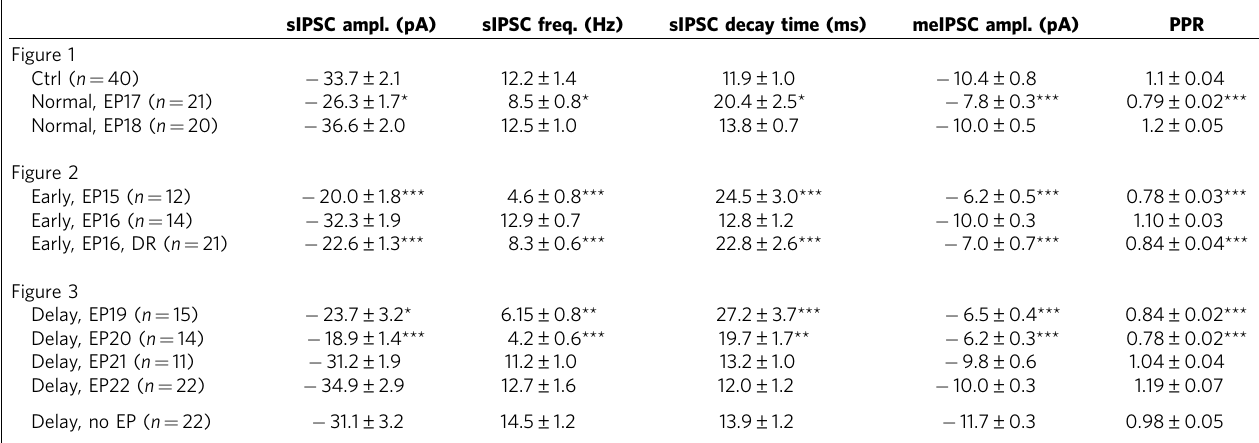
Table 1 | Visual experience regulates the inhibitory CP for sensitivity to hearing loss. sIPSC ampl. (pA) sIPSC freq. (Hz) sIPSC decay time (ms) meIPSC ampl. (pA) PPR Figure 1 Ctrl ( n ¼ 40)